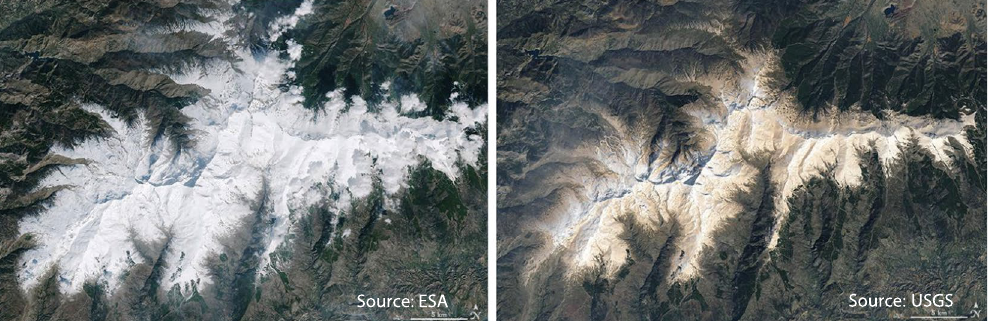
Figure 2. Aerial photography captured by the Sentinel 2-A (Left; courtesy of European Space Agency, ESA) and Landsat 8 (Right; courtesy of the U.S. Geological Survey) satellites corresponding to February 18 and February 27, 2017, after an intrusion of atmospheric dust over the Sierra Nevada National